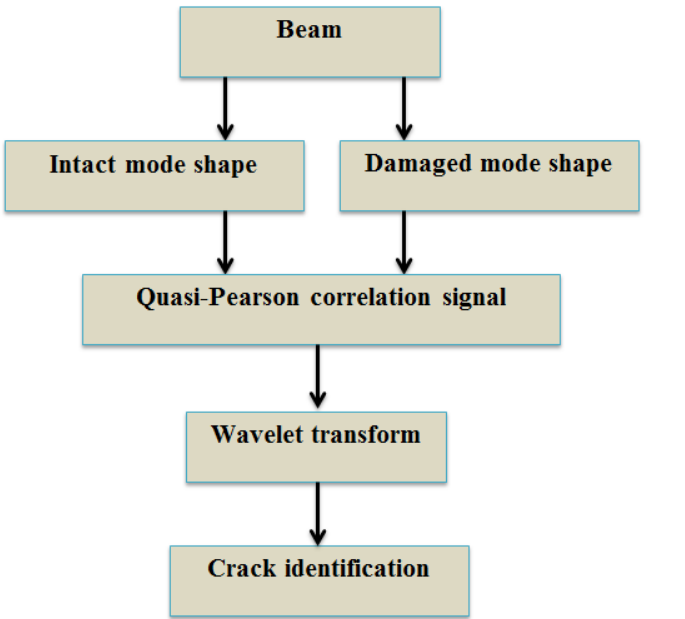
Figure 2. Flowchart of beam structure’s damage detection by combining the abilities of the Pearson- based correlation coefficient and the one-dimensional discrete wavelet transform.